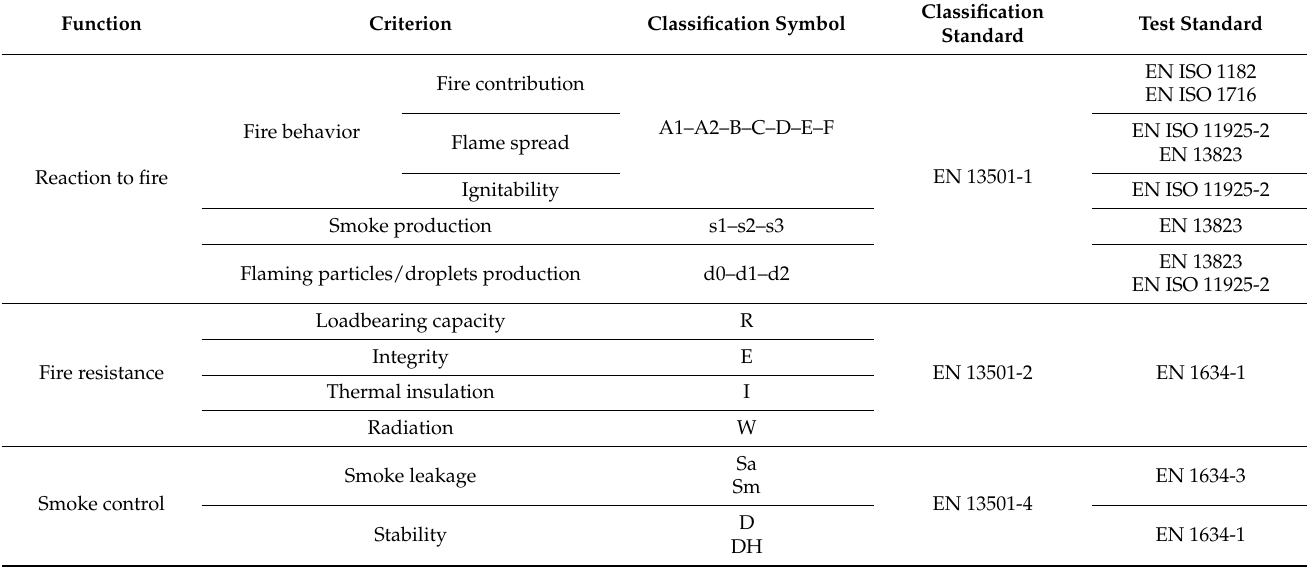
Table 1. Summary of the classification criteria for elements of passive fire protection [7,9–13,15–18].